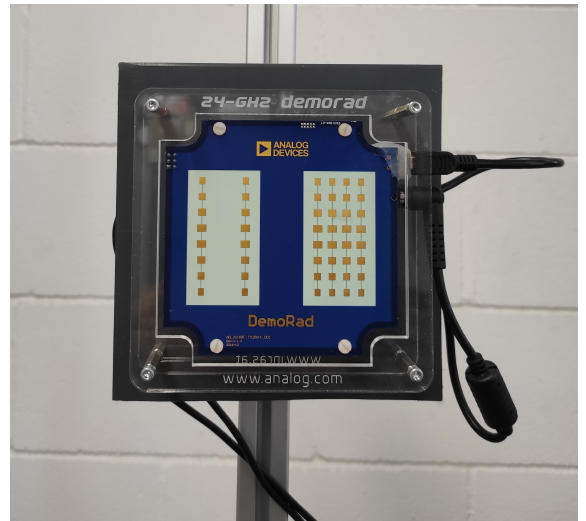
Figure 16. Image of EVAL-DEMORAD kit used in the